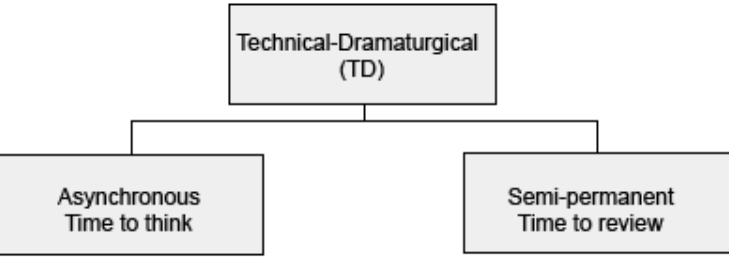
Figure 2 . Technical-dramaturgical categories.